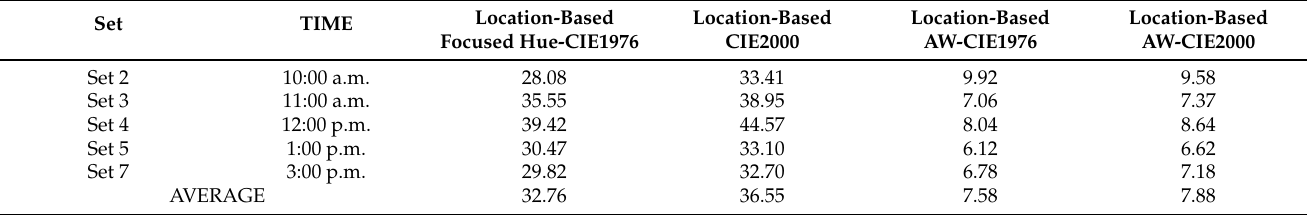
Table 5. Samsung S 10 average prediction rank using CIELAB colour model and CIE1976 and CIE2000 distance functions. Location-Based—Prediction using only prominent soil colours in Australian topsoils. AW—Proposed weight difference from Table 4.